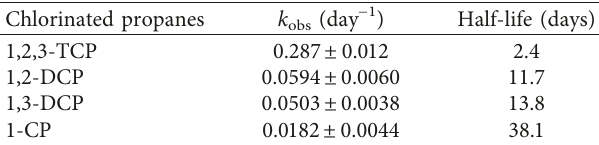
Figure 3: (a) Degradation of 1,2,3-TCP (12.27mg/l), 1,2-DCP (9.48 mg/L), 1,3-DCP (24.79 mg/L), and 1-CP (20.89mg/L) in the presence of 1mM · B 12 and 0.5g of µ ZVI; (b) degradation rates of 1,2,3-TCP, 1,2-DCP, 1,3-DCP, and 1-CP. Table 2: Pseudo-first-order reaction observed rate constants and half-lives .